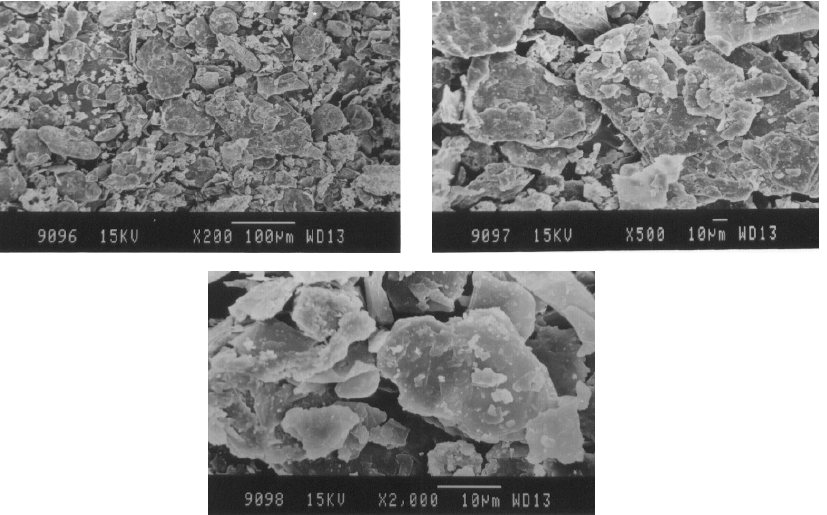
Figure 1. SEM photograph of Silk cotton hull activated carbon (SCH) at various magnifications (x200, x500 and